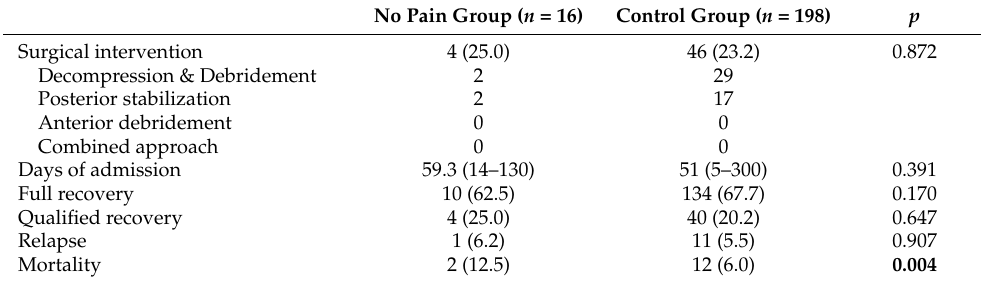
Table 4. Treatment